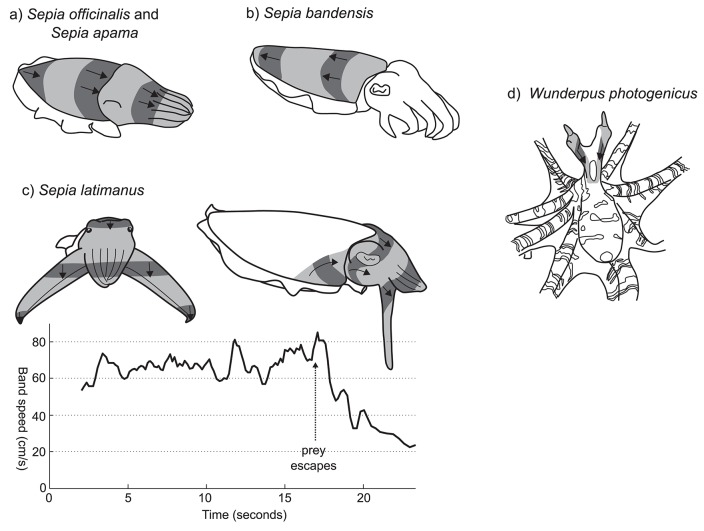
Rhythmic passing wave patterns. (a)
S. officinalis (redrawn from Hanlon and Messenger, 1996) and S. apama. (b)
S. bandensis. (c)
S. latimanus front view (left); lateral view (right). Graph shows the approximate change in speed of the banding pattern before and after aborting a predation attempt. Vertical arrow indicates the timing of prey escape. (d)
W. photogenicus. Image shading conventions as per Figure 3.